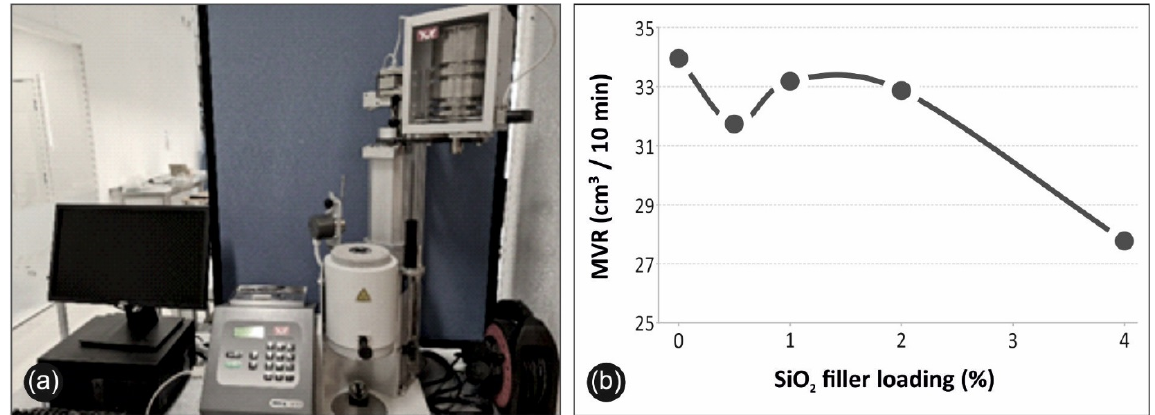
Figure 11. ( a ) Typical setup and equipment used for the MFI analysis, ( b ) MVR in cm 3 /10 min to silicon dioxide ratio (%) in nanocomposite.